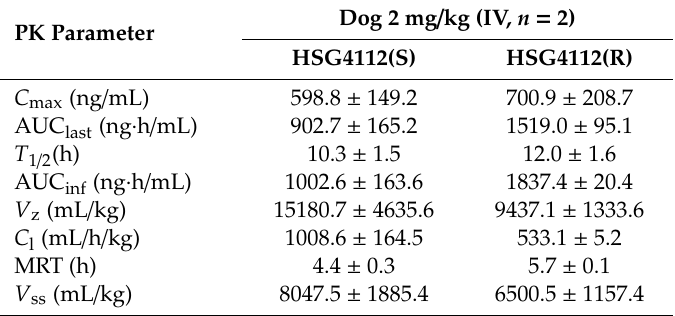
Table 4. Pharmacokinetic parameters of HSG4112(S) and HSG4112(R) after IV administration at a single dose of 2 mg/kg to dogs.